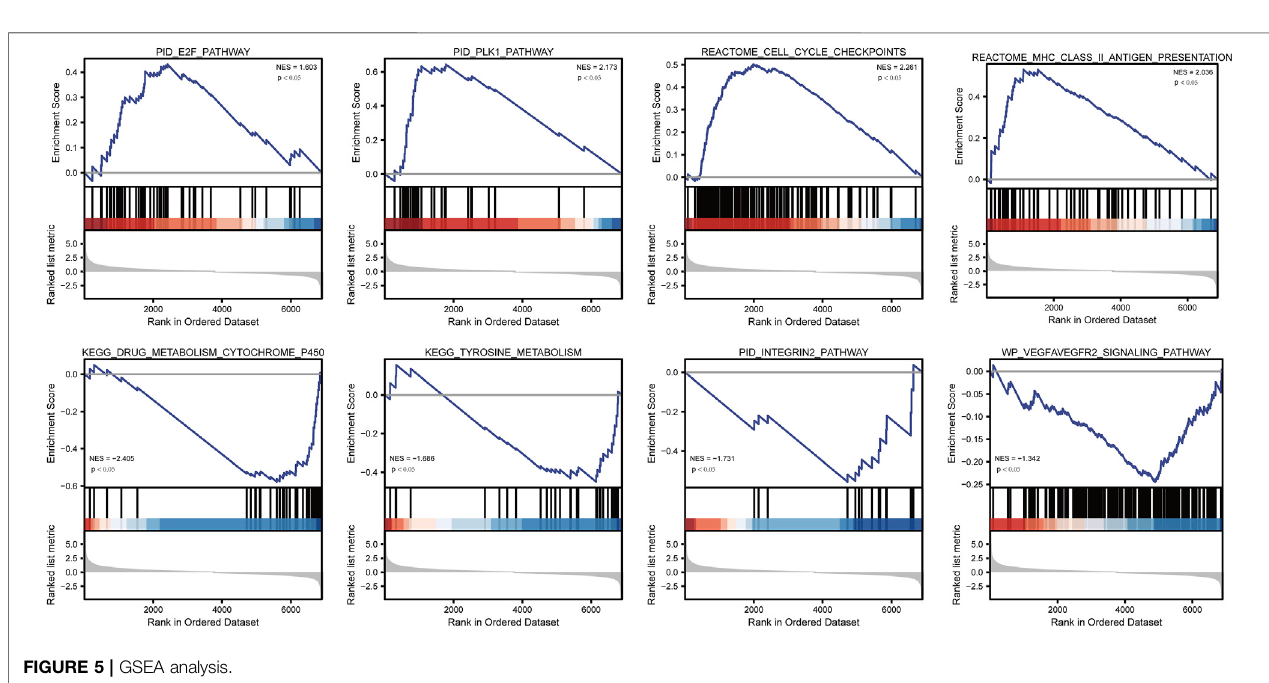
FIGURE 5 | GSEA analysis.